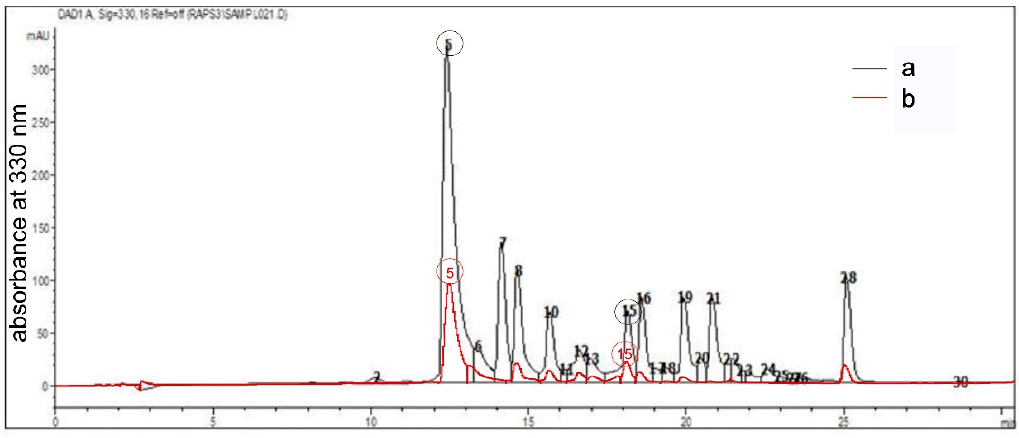
Figure 5. HPLC-chromatograms of alcohol extracts of wild-type seeds ( a ) and red seeds of plants without wax bloom, line 1169 ( b ). Wavelength 330 nm; peaks: 5-sinapine, 15-sinapic acid.